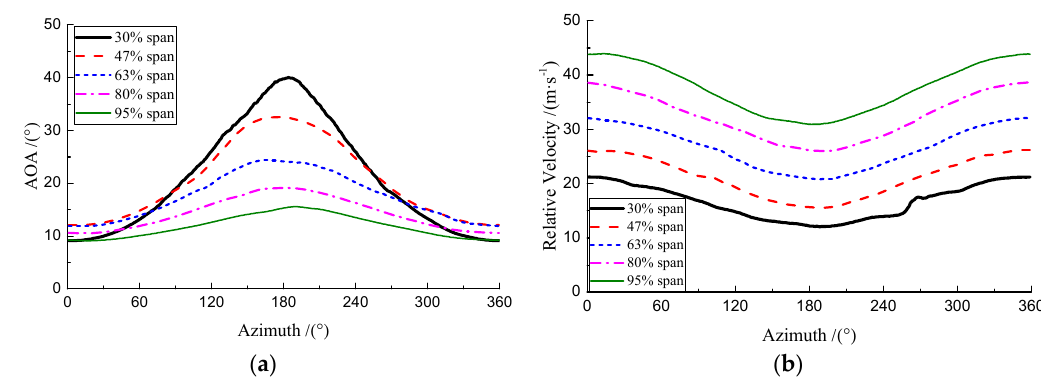
Figure 6. The variation of the angle of attack (AOA) and relative velocity with the azimuth at different spans. Wind speed is 13 m/s, and yaw angle is 30°. ( a ) AOA; ( b ) Relative velocity.